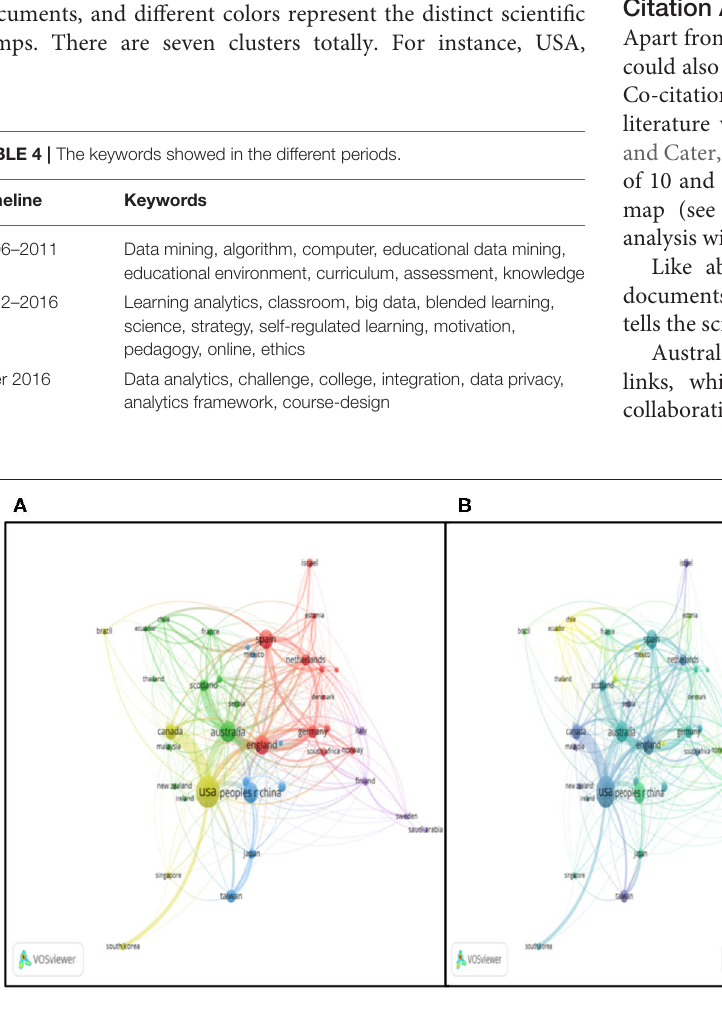
FIGURE 10 | Co-authorship analysis of countries/regions. (A) Network visualization map based on document weights; (B) Overlay visualization based on document weights; (C) Density visualization based on document weights.